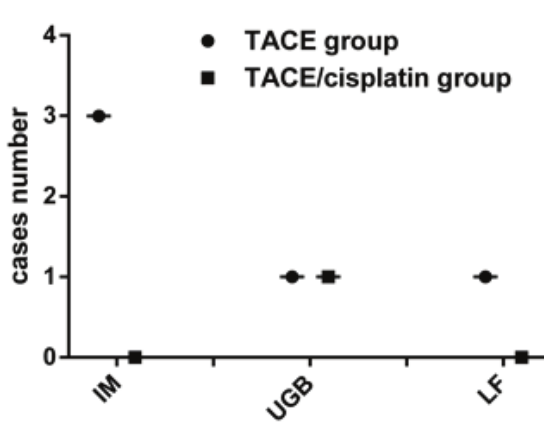
Figure 2: Difference in blood AFP in TACE group and TACE/cisplatin group